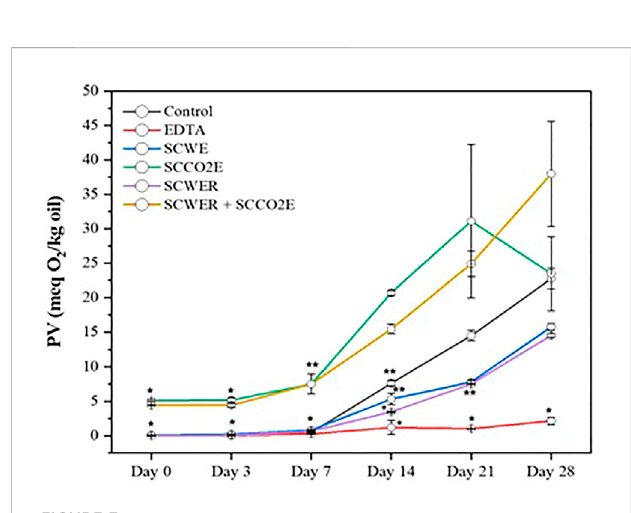
FIGURE 3 Development in peroxide value (PV) in mayonnaise with different antioxidants added (and control without antioxidants added) stored up to 28 days (dark, room temperature). Values with the same symbols are not signi fi cantly different ( p < .05). Mean ± sd ( n =